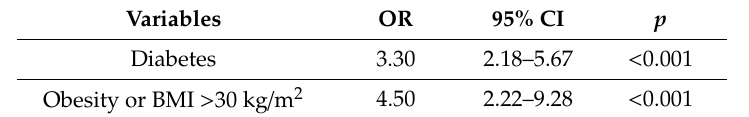
Table 3. Independent SSI-associated factors for both CABG and valve replacement patients.